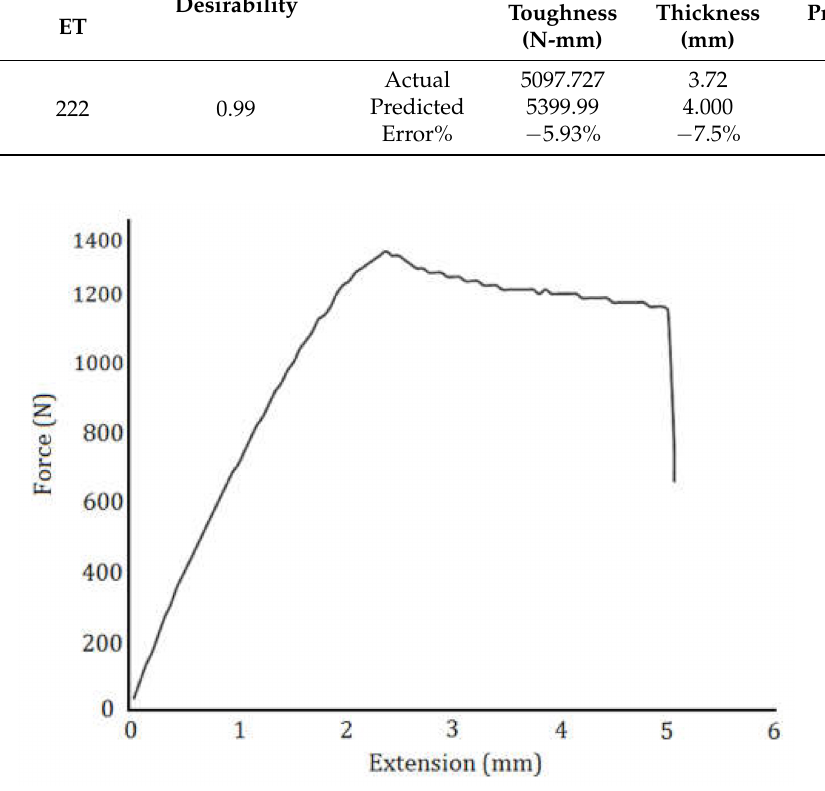
Figure 14. Extension–force diagram of the optimized